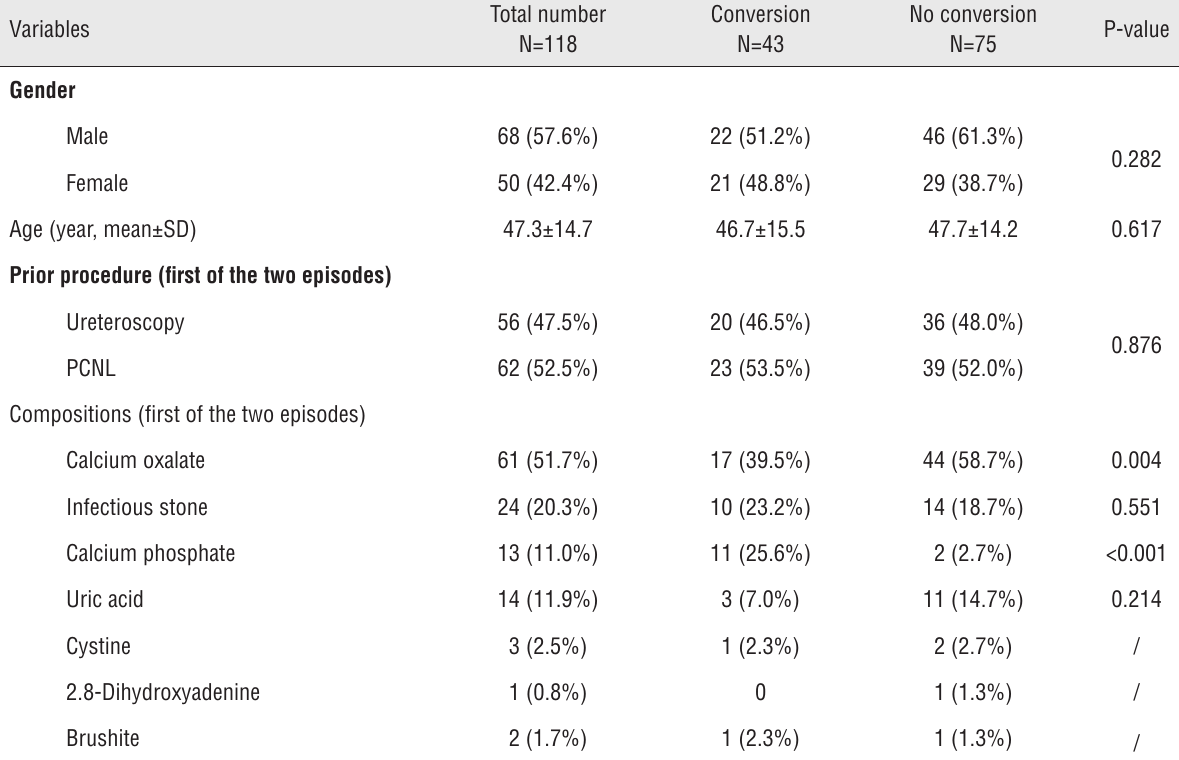
Supplementary Table 1 - Characteristics of patients with or without stone conversions in two